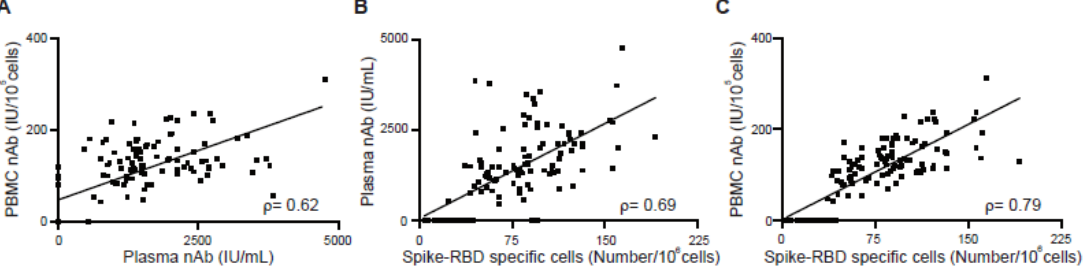
Figure 4. Correlation between neutralizing antibody titers in plasma or secreting by PBMC stimulation and spike-RBD-specific memory B cells. ( A ) Correlation of neutralizing IgG in plasma with neutralizing IgG levels from in vitro stimulation. ( B ) Correlation of neutralizing IgG in plasma with spike-RBD-specific MBCs in PBMC samples. ( C ) Correlation of neutralizing IgG levels from in vitro stimulation with spike-RBD-specific MBCs in PBMC samples. Correlations were calculated using non- parametric Spearman’s rank correlation and are shown with linear trend lines. All data were statistically significant with